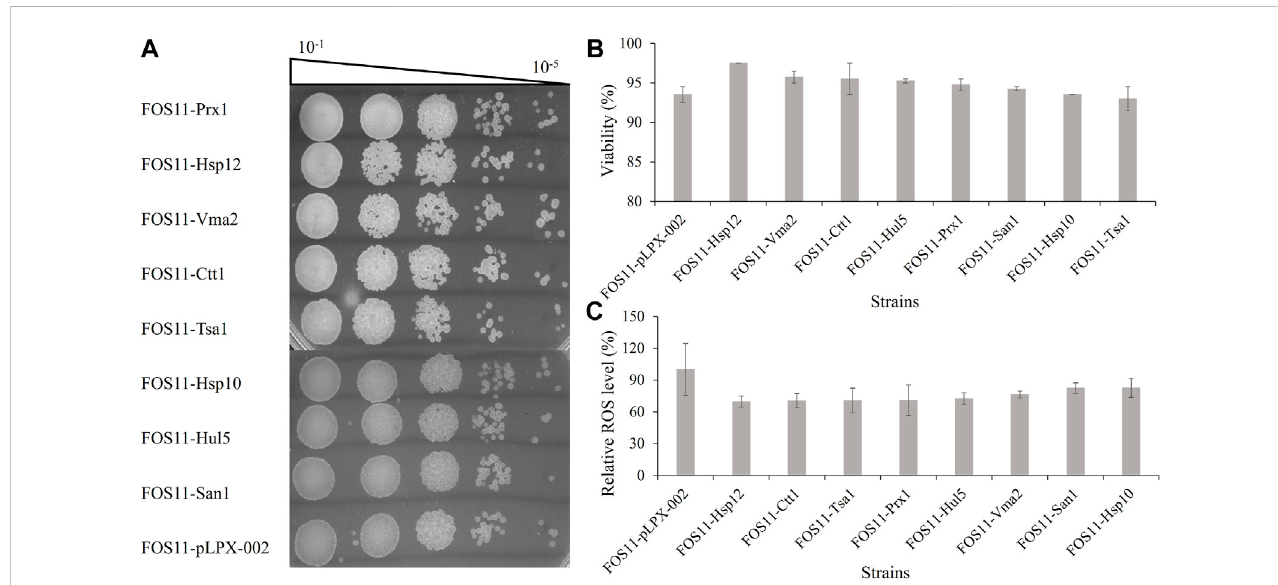
FIGURE 2 Characterization of the engineered strains treated with 50 mM H 2 O 2 . (A) . Investigation of colony forming units of the engineered and control strains by spotted plate method. (B) . Detection of cell viability based on the fl uorescent dye of engineered and control strains by fl ow cytometry. (C) . Measurement of the intracellular ROS levels of engineered and control strains based on the fl uorescent by microplate